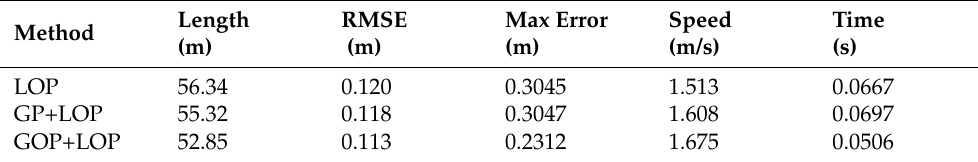
Table 1. Quantitative comparison of different trajectory generation